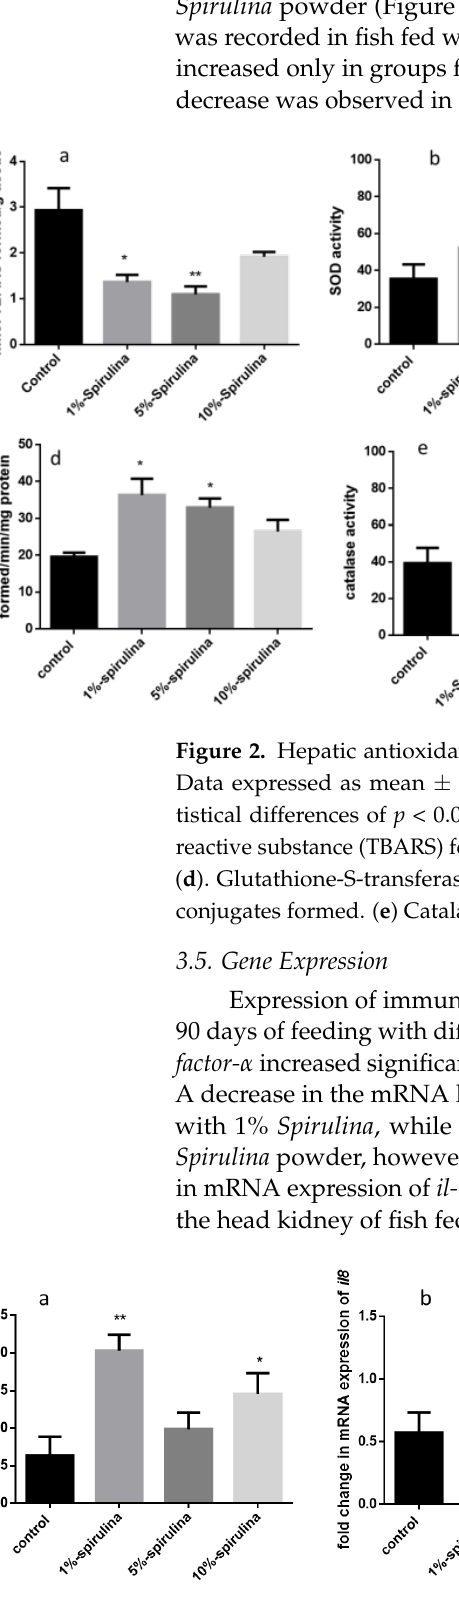
Figure 3. Relative mRNA expression of tnf- α ( a ), il-8 ( b ) and ifn- γ ( c ) in head kidney of grass carp fed with 0, 1, 5 and 10% Spirulina for 90 days. Values are presented as mean ± S.E.M. * = p < 0.05; ** = p < 0.01.